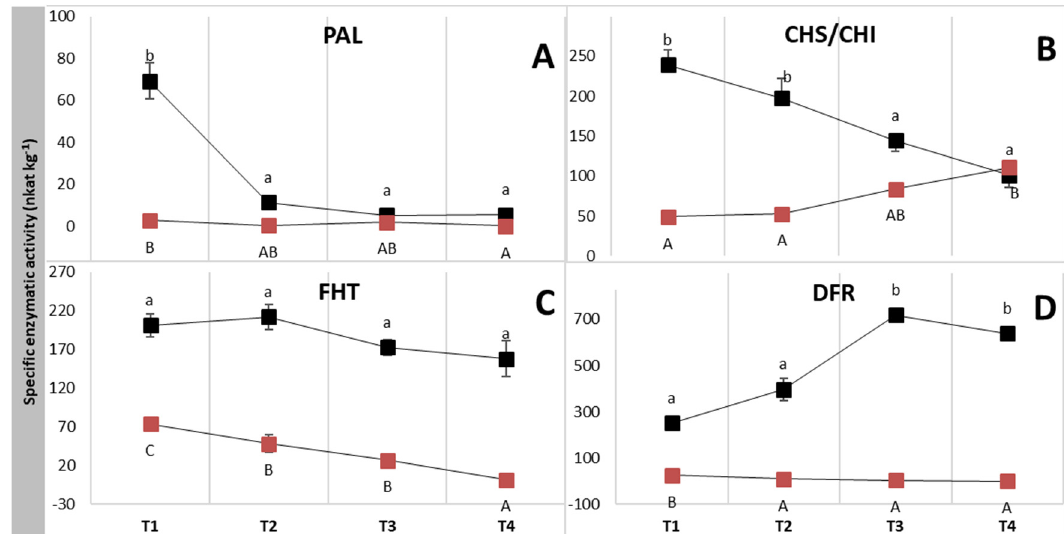
Figure 5. Specific enzymatic activities of PAL—phenylalanine ammonia-lyase ( A ), CHS/CHI—chalcone synthase/chalcone isomerase ( B ), FHT—flavanone 3 β -hydroxylase ( C ) and DFR—dihydroflavonol-4-reductase ( D ) (nkat kg − 1 ) in NIGRA ( ■ ) and VIRIDIS ( ■ ) berries during different developmental stages (T1–T4). Different small letters (a–b) denote statistically significant differences between developmental stages for the NIGRA genotype, and different capital letters (A–C) denote statistically significant differences between developmental stages for the VIRIDIS genotype obtained with the Duncan test ( p < 0.05). Data are presented as average value ± standard error ( n = 4).